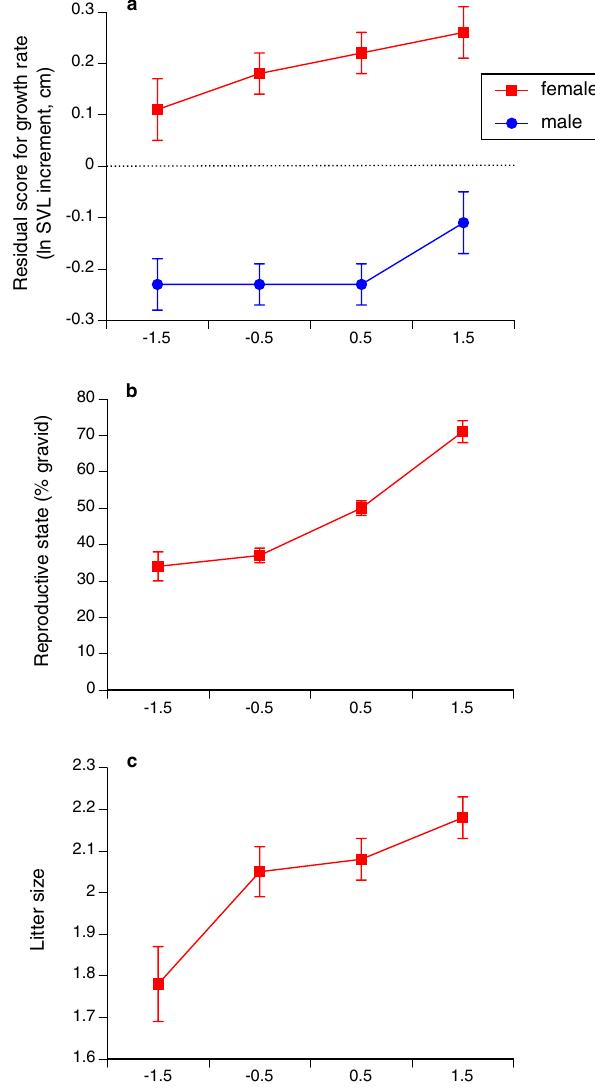
Figure 2. Relationships between the head shape (width relative to length) of a turtle-headed sea snake Emydocephalus annulatus , and ( a ) the snake’s growth rate (increment in snout-vent length [SVL] per year), ( b ) reproductive state (gravid or not) and ( c ) litter size. Relative head-width values are combined into categories to facilitate visualisation of trends; each interval of relative head length shows mean value and associated standard error for the relevant